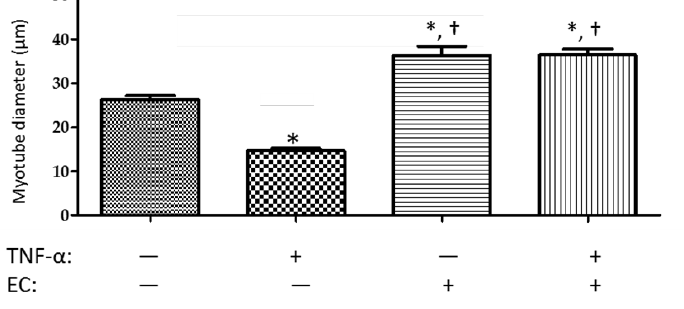
Figure 3. Hypertrophy effects of EC on the myotube size. C2C12 cells were induced to differentiate, followed by presence or absence of TNF- α (100 ng/mL) and/or EC (2.5 mg/mL) added together as a co-treatment. ( A ) Representative images of the C2C12 myotubes following 72 h treatment in the presence and absence of TNF- α and/or EC observed by microscopy ( ×100 magnification). ( B ) Measurement of average myotube diameter after 72 h treatment. Diameter was assessed by CellSens based on three independent fields per sample, with 15 myofibers randomly selected per field. Results are presented as the mean diameter ± SEM. Differences from control (without TNF- α or treatment) are shown as * p < 0.05, while differences from TNF- α alone are shown as † p <